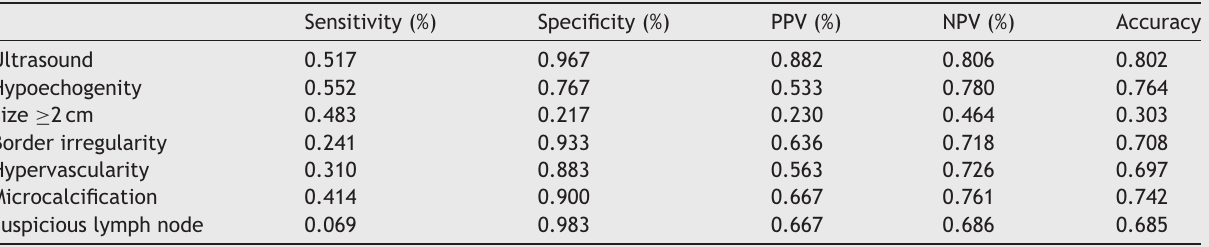
Diagnostic performances of suspicious sonographic characteristics of thyroid